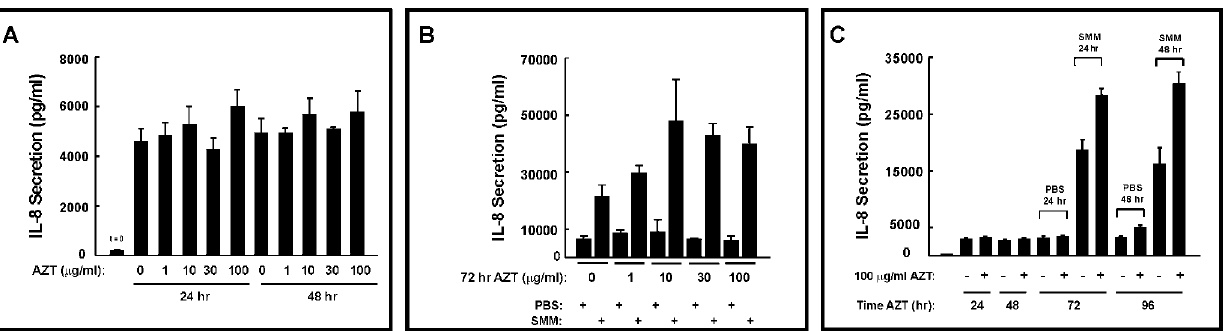
Figure 6. Effect of AZT on IL-8 secretion in human airway epithelia. A: AZT does not affect basal airway epithelial IL-8 secretion. Basal IL-8 secretion from well-differentiated primary cultures of normal human bronchial epithelia serosally exposed to different doses of AZT for 24 hr and 48 hr. B: Dose response for AZT-potentiated IL-8 secretion triggered by 24 hr mucosal exposure of HBE to supernatant from mucopurulent material (SMM) from CF airways. Well-differentiated primary cultures of normal human bronchial epithelia were pretreated with AZT for 72 hr and exposed to mucosal PBS or SMM during the last 24 hr of macrolide treatment. C: Time course for AZT-potentiated SMM-induced IL-8 secretion. Vehicle or 100 m g/ml AZT were added to the serosal surface of well-differentiated normal HBE and a 48 hr time course performed for IL-8 secretion. AZT pretreatment did not alter the basal levels of secreted IL-8, but potentiated SMM-induced IL-8 secretion at both 24 and 48 hr (corresponding to 72 and 96 hr AZT treatment, respectively).